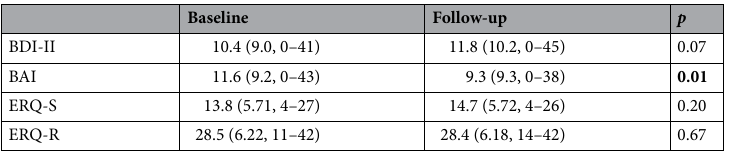
Table 1. Self-report measures of depressive symptoms (BDI-II), anxiety symptoms (BAI), expressive suppression (ERQ-S), and reappraisal (ERQ-R) at baseline and at the one-year follow-up. Significant changes are in bold. BDI-II Beck Depression Inventory, BAI Beck Anxiety Inventory, ERQ-S Emotion Regulation Questionnaire-Expressive Suppression scale, ERQ-R Emotion Regulation Questionnaire-Reappraisal scale.